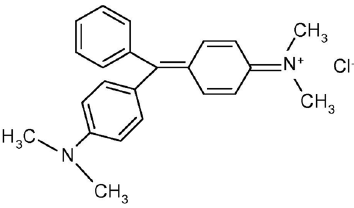
Fig. 1 Structural formula of malachite green